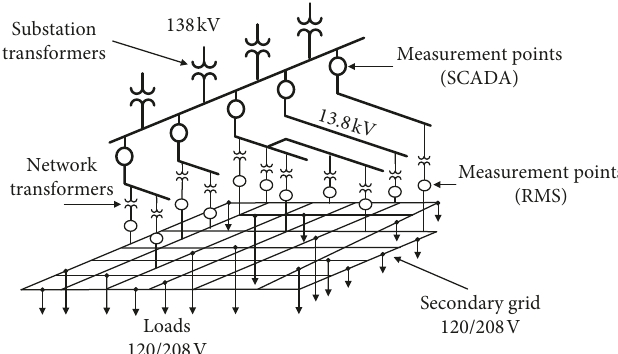
Figure 1: Topology of a typical secondary network. The secondary network is highly meshed. The only real-time measurements are the SCADA at the substation and the remote monitoring system (RMS) at the secondary of the network transformers.